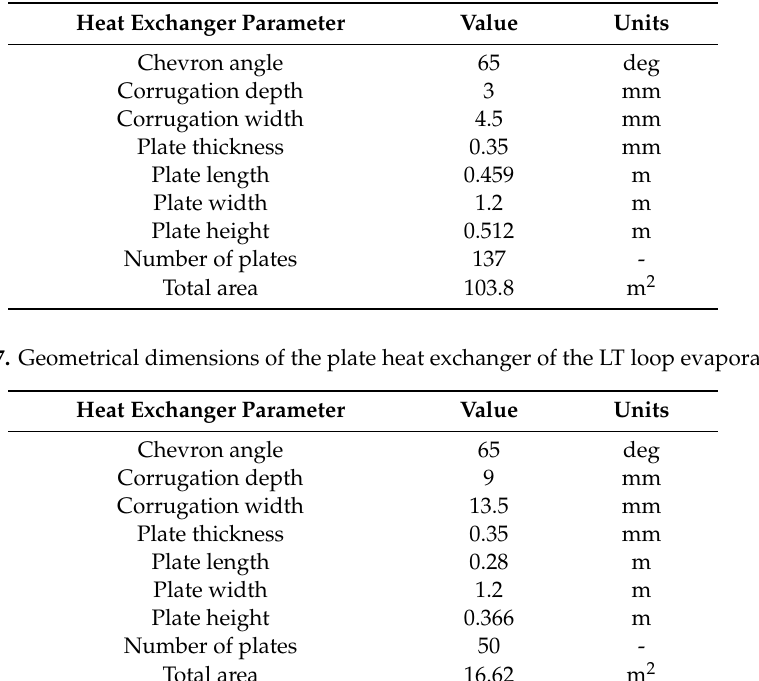
Table 6. Geometrical dimensions of the plate heat exchanger of the preheater of the LT loop.